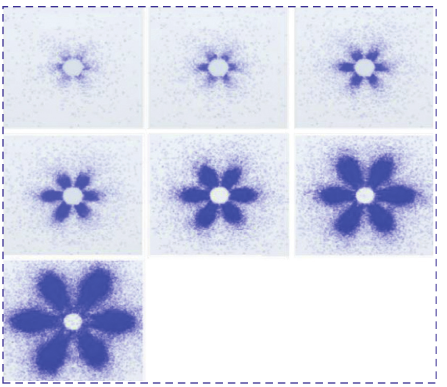
Figure 3: Influence range chart under each